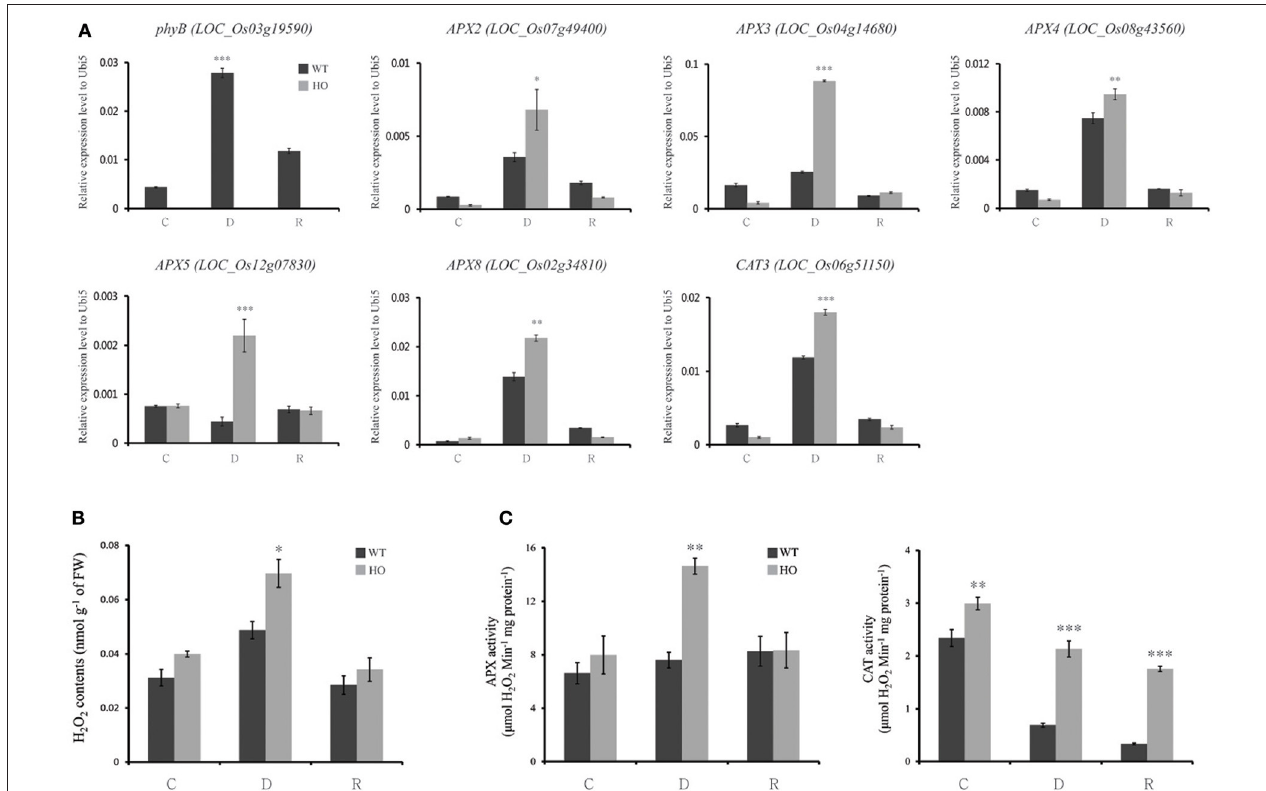
FIGURE 9 | Comparison of transcripts of ROS-relating genes, H 2 O 2 contents, and ROS-scavenging enzymatic activity between WT and phyB mutant. Analyses of transcripts of phyB , APX2, APX3, APX4, APX5, APX8, and CAT3 (A) , H 2 O 2 contents (B) and enzymatic activity of APX and CAT (C) in roots of WT and phyB (HO) mutant under before drought (control), after drought and recovery. The expression levels were normalized to that of Ubi5 using real-time polymerase chain reaction (A) . As the biological replicates, we used different three samples. The error bars of the each sample means ± SD ( n = 9) (B,C) . WT, wild-type segregants of T-DNA insertional line in PhyB ; HO, homozygote; C, control; D, drought treatment for 3 d; R, recovery for 7 d after drought treatment. * P < 0.05; ** P < 0.01; *** P < 0.001.